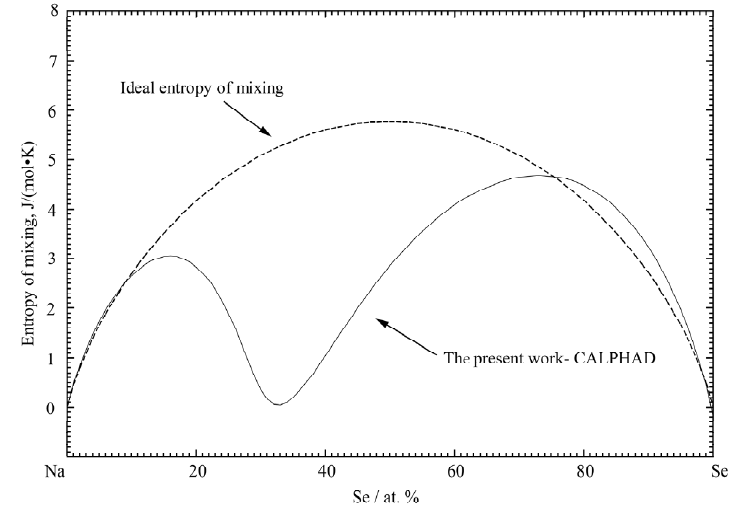
Figure 10. The calculated entropy of mixing for the liquid phase of the Na-Se binary system at 1400 °C.